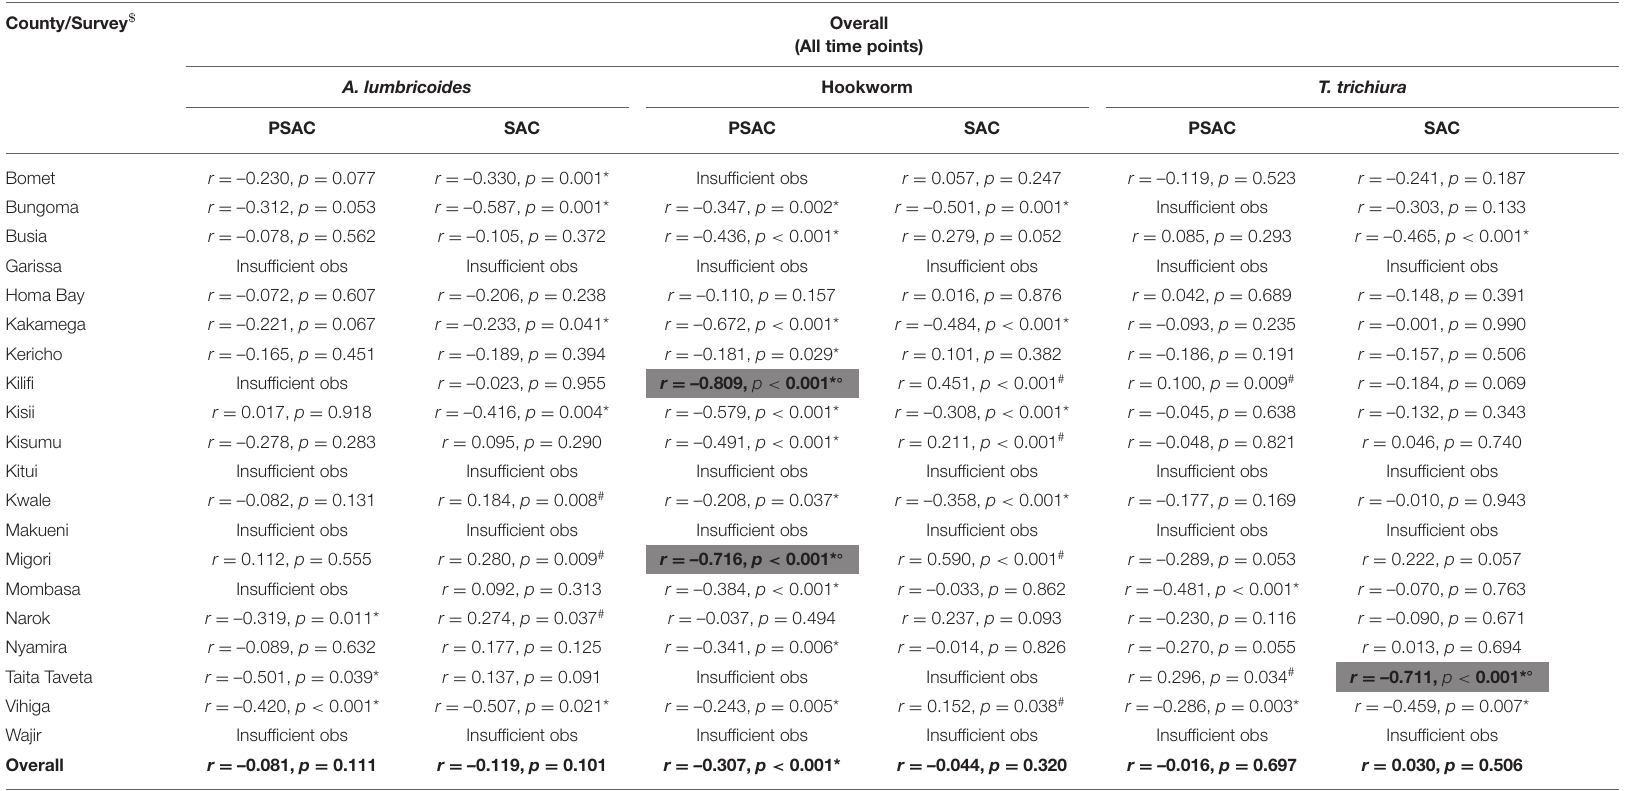
TABLE 7 | Overall correlations between pre-treatment differentiated STH prevalence of infection and previous year treatment coverage by county among pre-school (PSAC) and school (SAC) aged group of children in